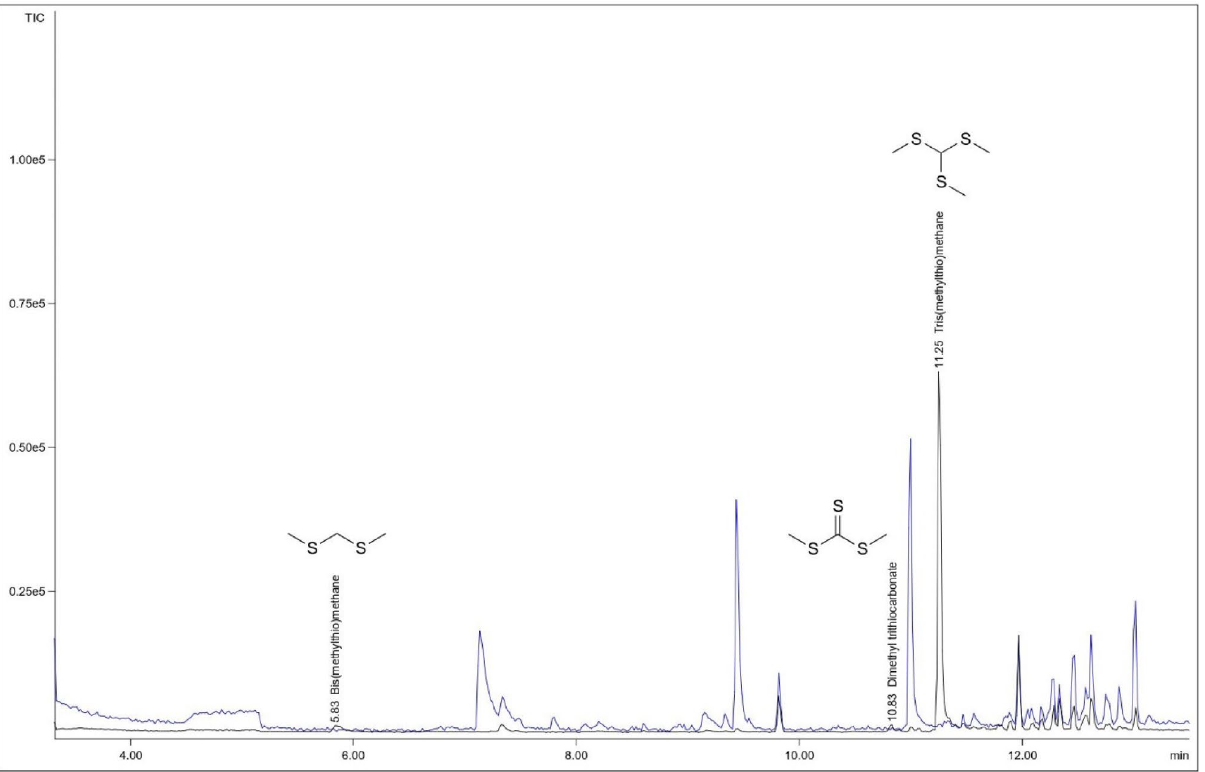
Figure 1. GC–MS chromatogram of the headspace of M. hyalina (black) and the growth medium alone (blue). Identified signals are not present in the headspace of the growth medium. The three strong signals in the chromatogram of the headspace of the growth medium could be identified by MS and RI as benzaldehyde (7.13 min) nonanal (9.44 min), and decanal (11.00